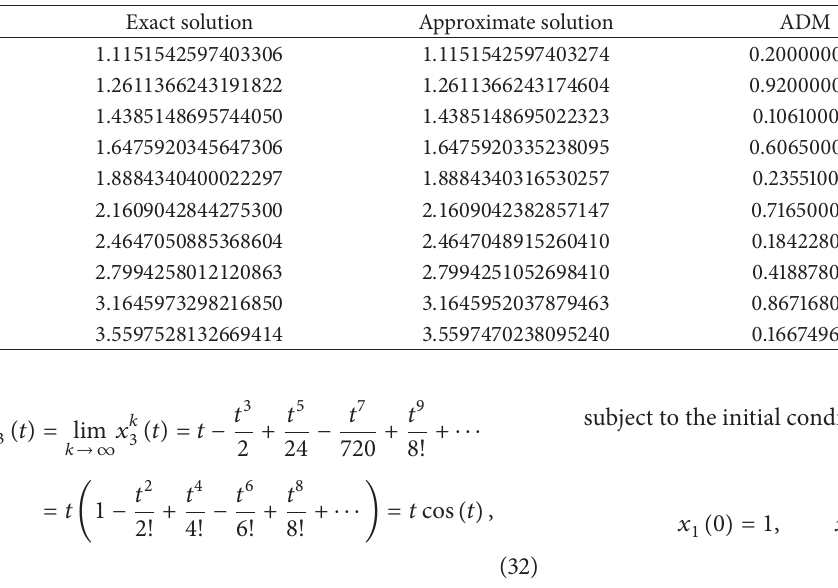
Table 2: Numerical comparison of the exact error function Ext 8 (𝑡) for 𝑥 2 (𝑡) to Example 1 in [0, 1]